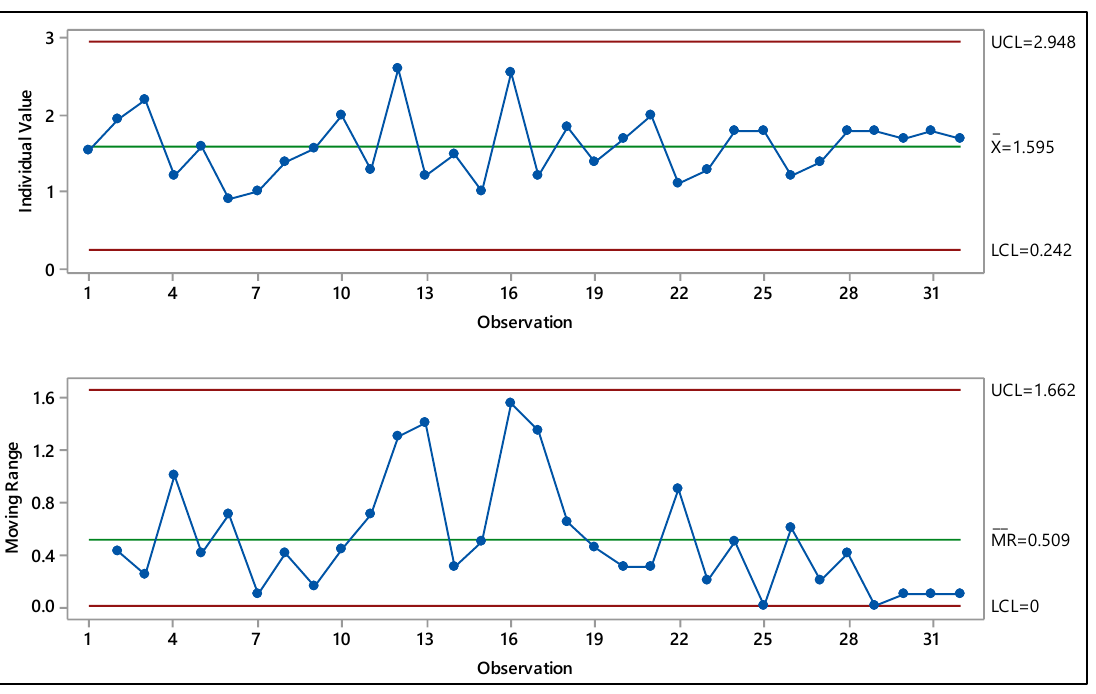
Figure 3: I&MR chart for R